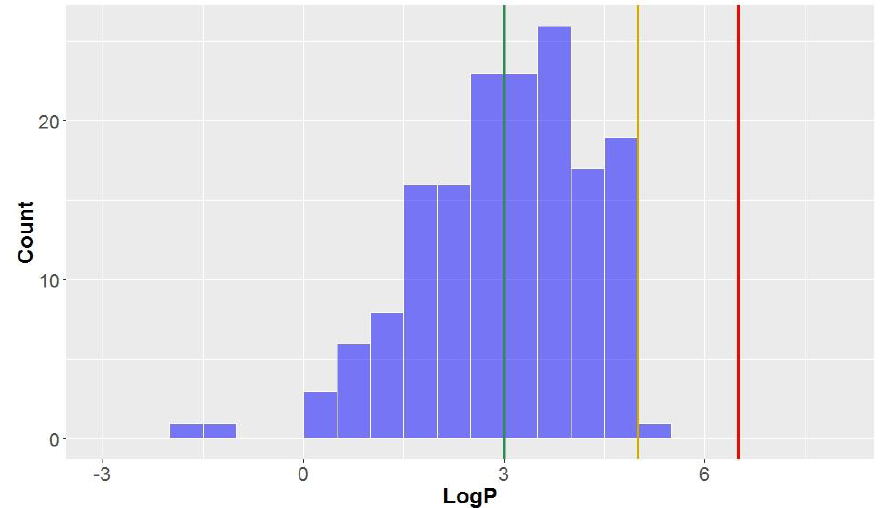
Figure 4. The statistical distribution of the octanol–water partition coefficient (LogP) of all analysed compounds (green = 3, compounds < 3 are in the lead-like space; yellow = 5, compounds < 5 are in the drug-like space; red = 6.5, compounds < 6.5 are in the KDS). Total number of compounds = 160.